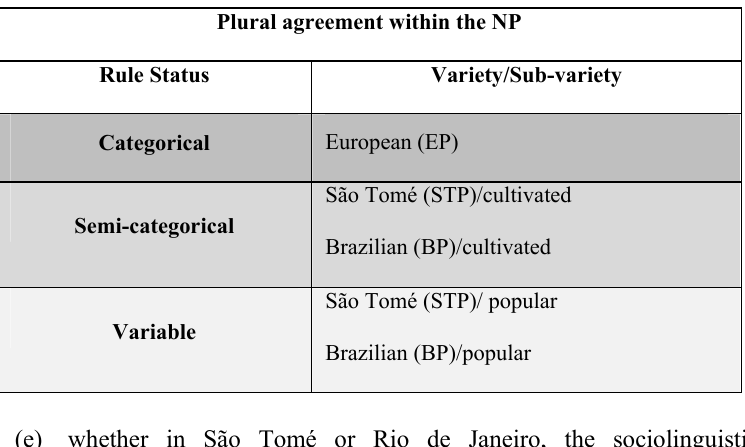
Table XVII. Plural agreement within the NP: rule status in three varieties of